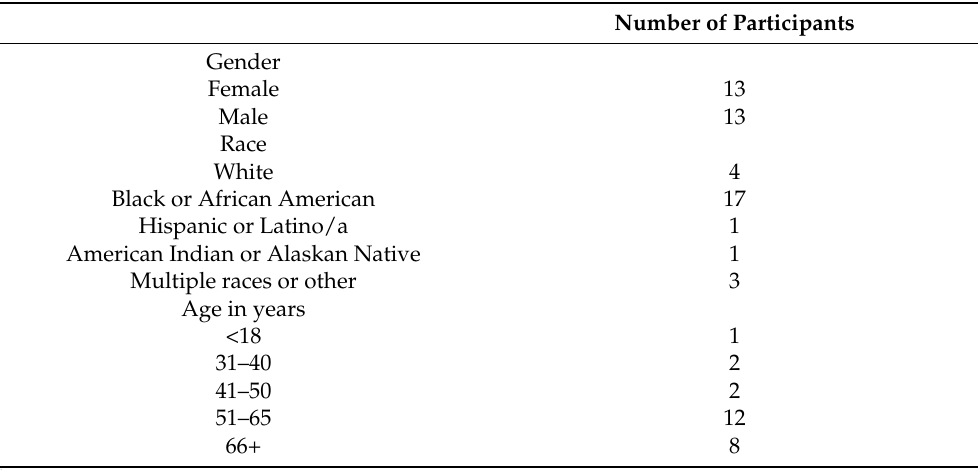
Table 1. Demographic characteristics of participants 1